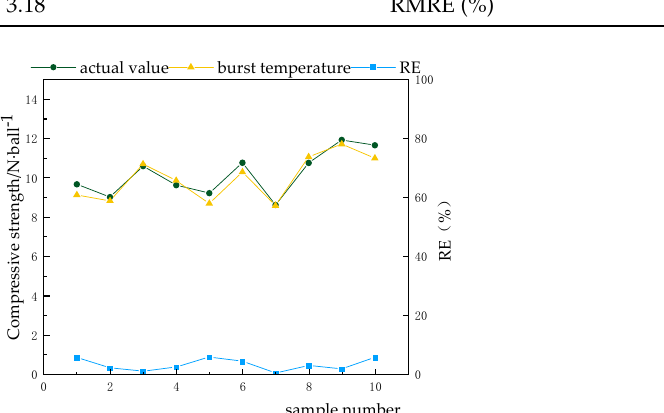
Table 11. Comparison of falling strength prediction results.